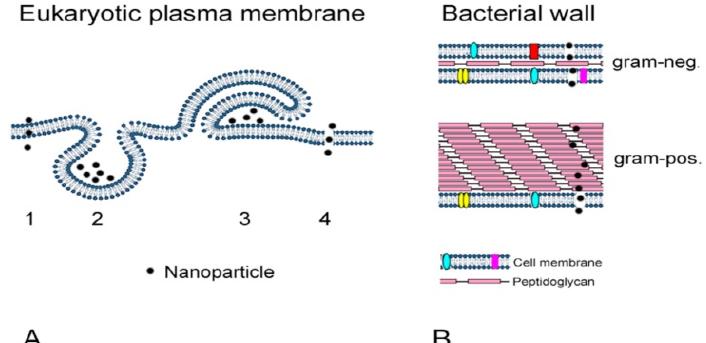
Figure 2. Uptake of AgNPs by mammalian cells ( A ) and by bacteria ( B ). ( A ) AgNPs can cross the plasma membrane by diffusion ( 1 ), endocytotic uptake ( 2 , 3 ), and disruption of membrane integrity ( 4 ). ( B ) AgNPs permeate the cell walls of gram-negative and gram-positive bacteria. Reproduced from